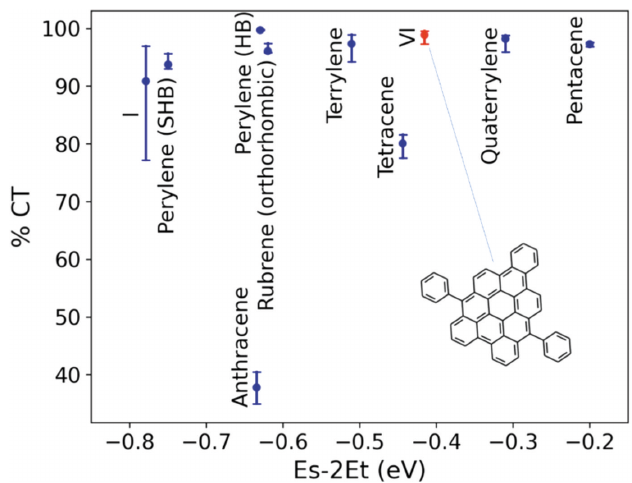
Figure 8 A two-dimensional descriptor for assessing SF candidates. The thermo- dynamic driving force for SF ( E s (cid:0) 2 E t ) is displayed on the x axis and the singlet exciton charge-transfer character (%CT) is displayed on the y axis. The error bars correspond to the range of %CT values obtained by using different hole positions when performing the double-Bader analysis. Compounds I and VI (the latter highlighted in red) are compared to some acene and rylene